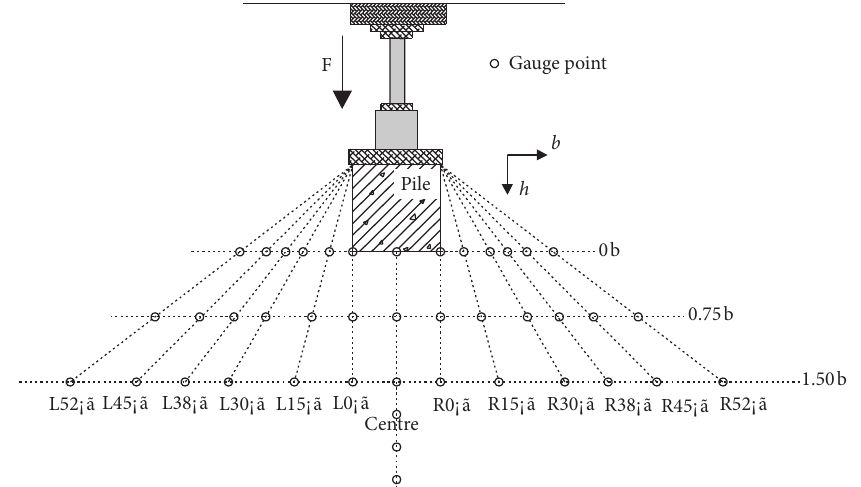
Figure 6: Overhead view of the layout of gauge points.